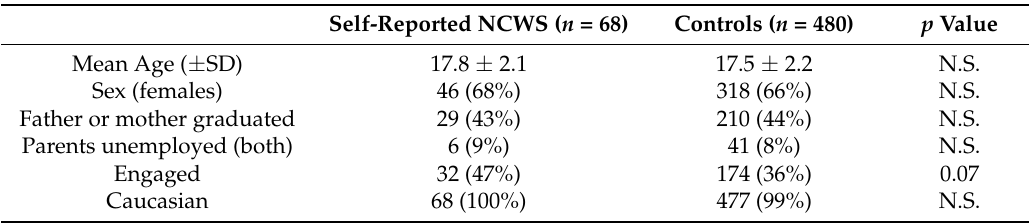
Table 1. Demographic characteristics of the subjects with self-reported Non-Celiac Wheat Sensitivity (NCWS) and the controls (number and percentage are